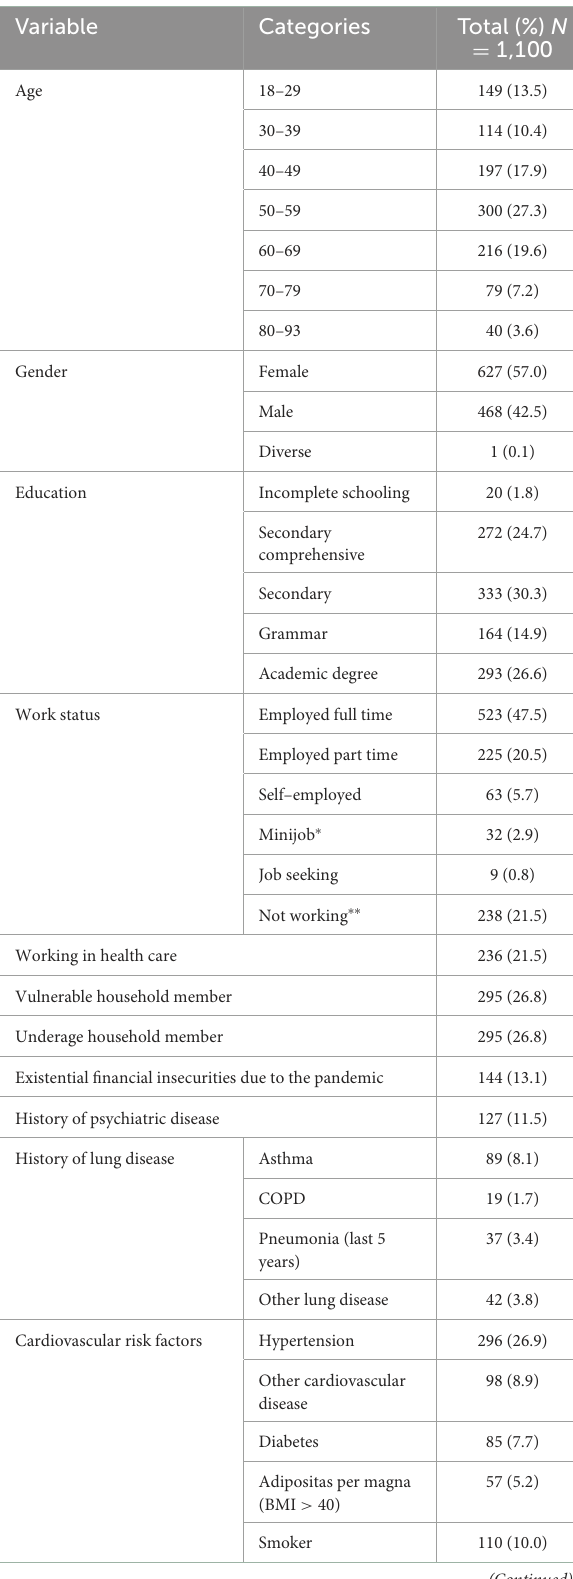
TABLE 1 Sociodemographic characteristics of the survey